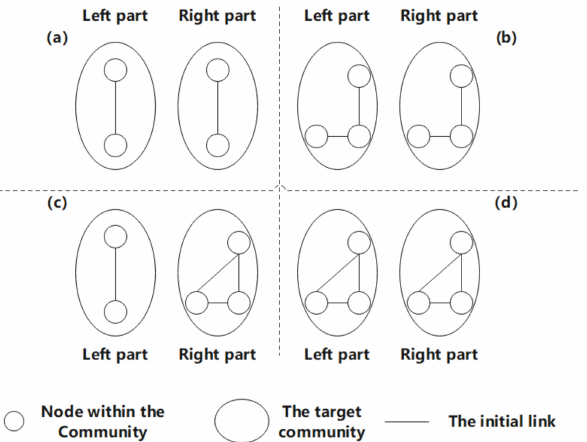
Figure 2. A more complex interaction hierarchy between two entities in an opportunistic social network. ( a ) Two entities that both contain two nodes; ( b ) Two entities containing two nodes and three nodes; ( c ) Two entities that each contain three nodes; ( d ) Two entities that each contain three